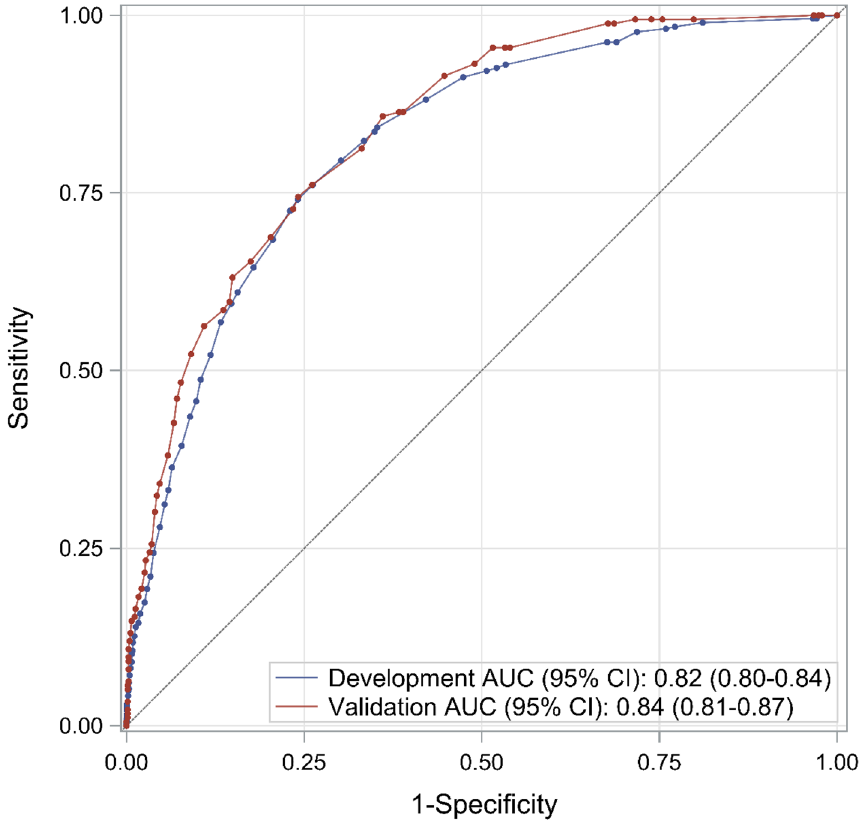
Figure 2. Receiver operating characteristic curve of predictive risk-score model for opioid overdose. AUC area under the receiver operating characteristic curve, CI confidence interval.